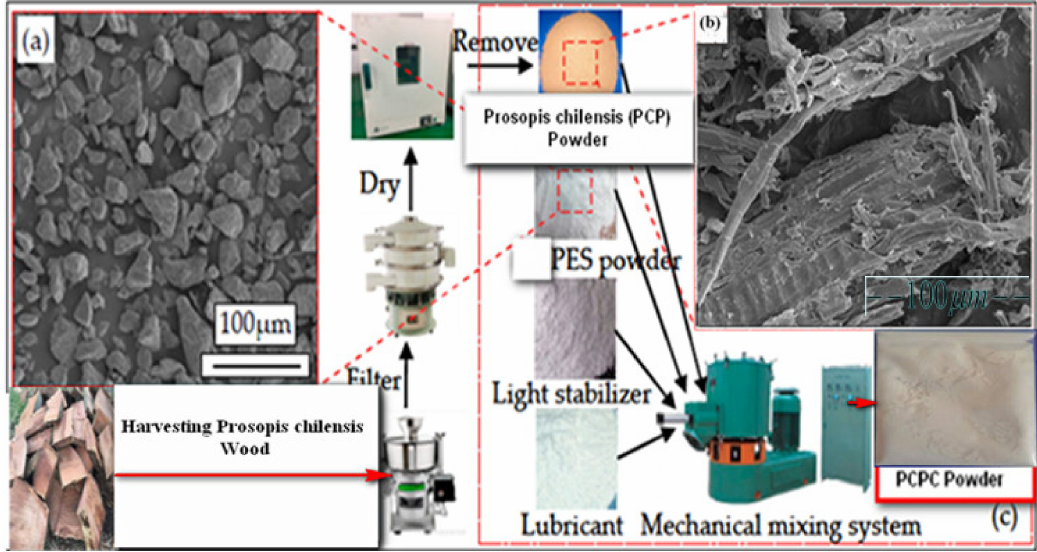
Figure 1. Preparation of the Prosopis chilensis / polyethersulfone composite (PCPC), with SEM micrographs of the ( a ) polyethersulfone (PES) powder particle morphology, ( b ) Prosopis chilensis powder (PCP) particle morphology, and a digital photograph of the ( c ) PCPC powder after mechanical